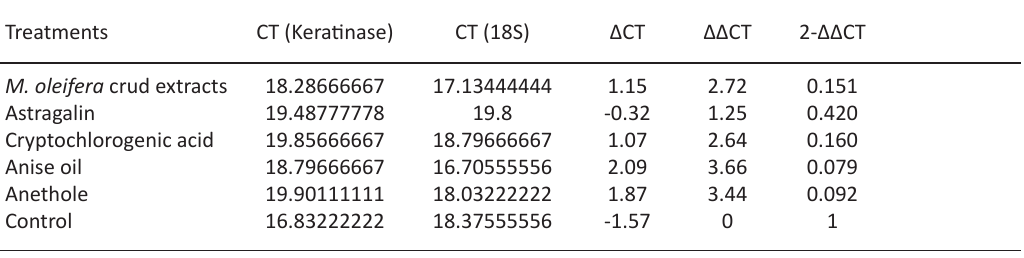
Table 2B. The analysis of the Keratinase gene’s relative gene expression for the T. rubrum KP979787 (ΔΔCT) Technique Treatments